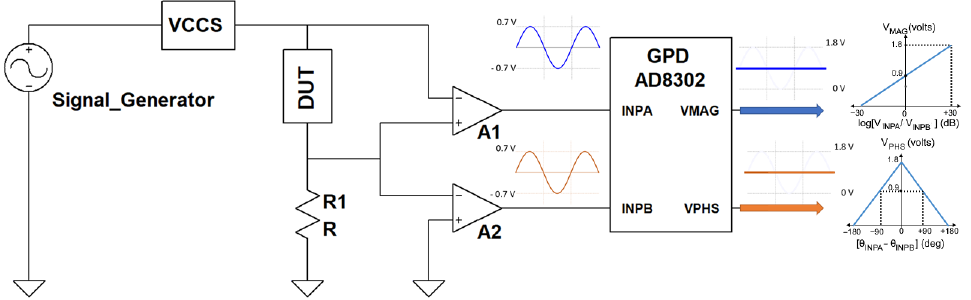
Figure 1. Gain phase detector measurement technique using